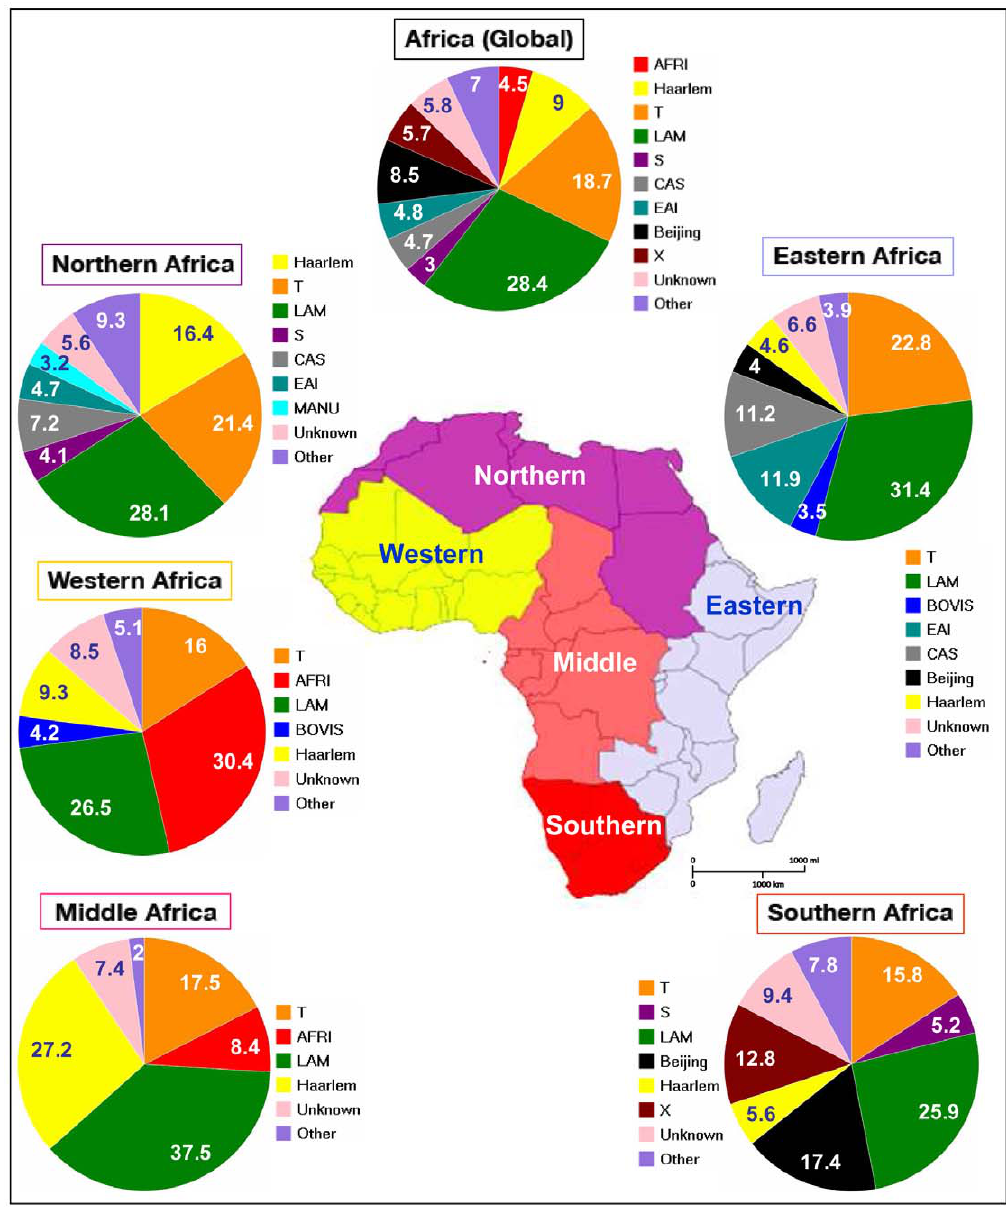
Figure 1. Geographical distribution of spoligotyping-based genotypic lineages of Mycobacteriumtuberculosis in various subregions of Africa (n=11956 clinical isolates) in the SITVIT2 database.